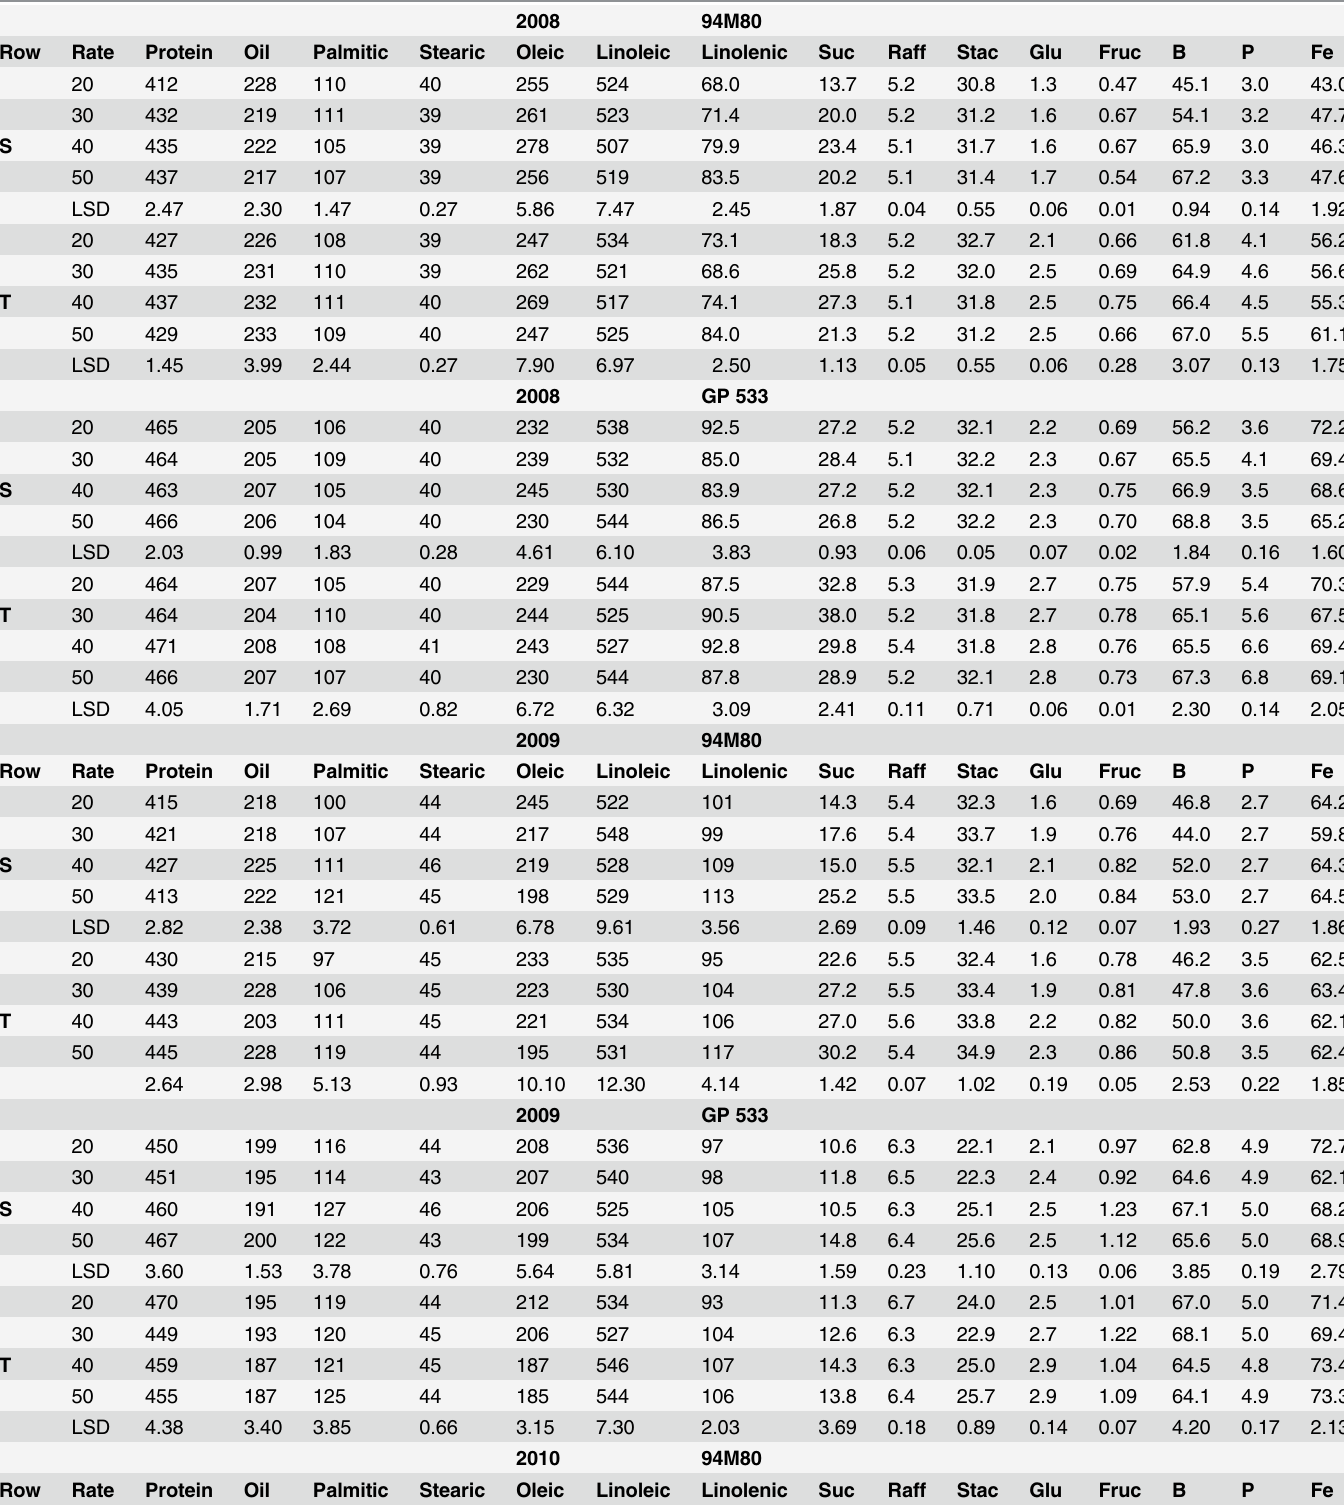
Table 6. Effects of row-type (single, S, or twin, T) and seeding rate (SR, seed m -2 ) on seed protein, oil, fatty acids (g kg -1 ), sucrose (Suc), raffinose (Raff), stachyose (Stac), glucose (Glu), fructose (Fruc) (mg g -1 ), boron (B, mg kg -1 ), phosphorus (g kg -1 ), and iron (Fe, mg kg -1 ) in two soybean culti- vars (94M80 and GP-533) in Beulah fine sandy loam